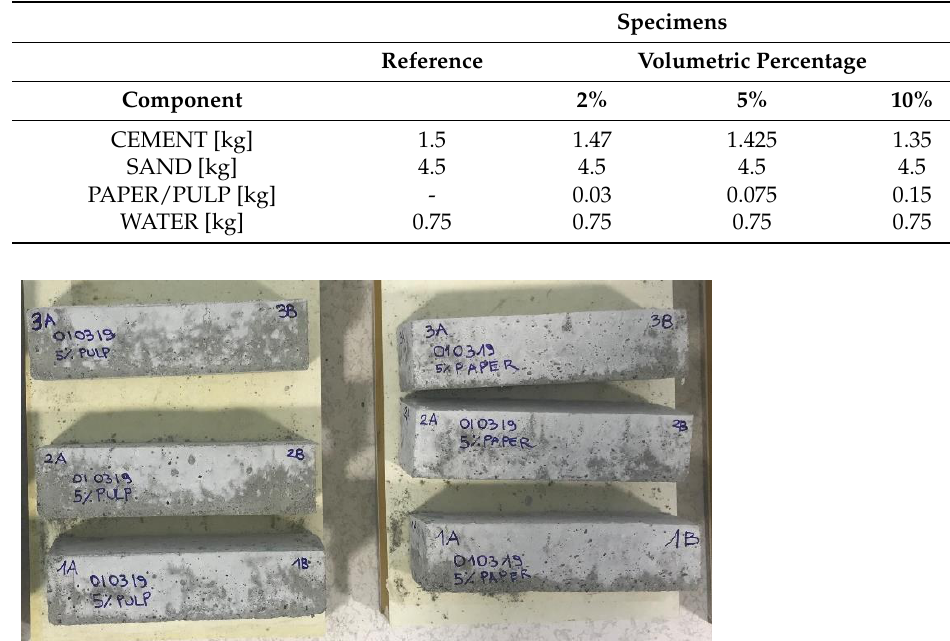
Table 1. Components proportioning for obtaining the specimens to be tested.